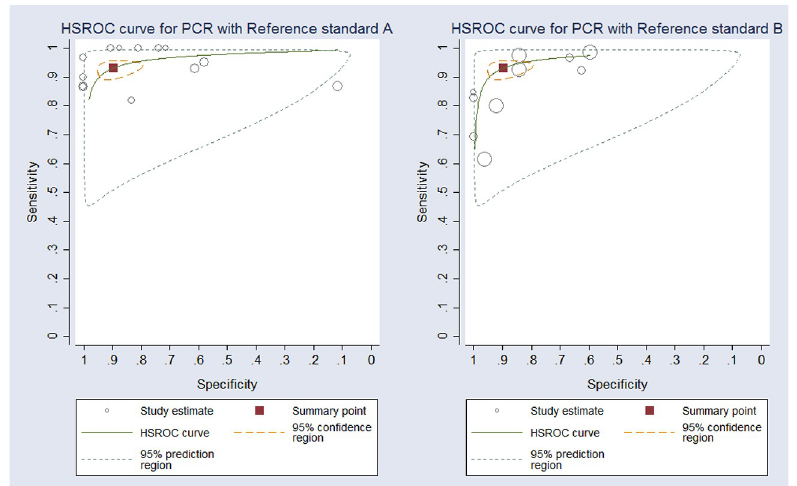
PLOS NeglectedTropical Diseases | https://doi.org/10.1371/journal.pntd.0007981 January 21, 2020 10 /